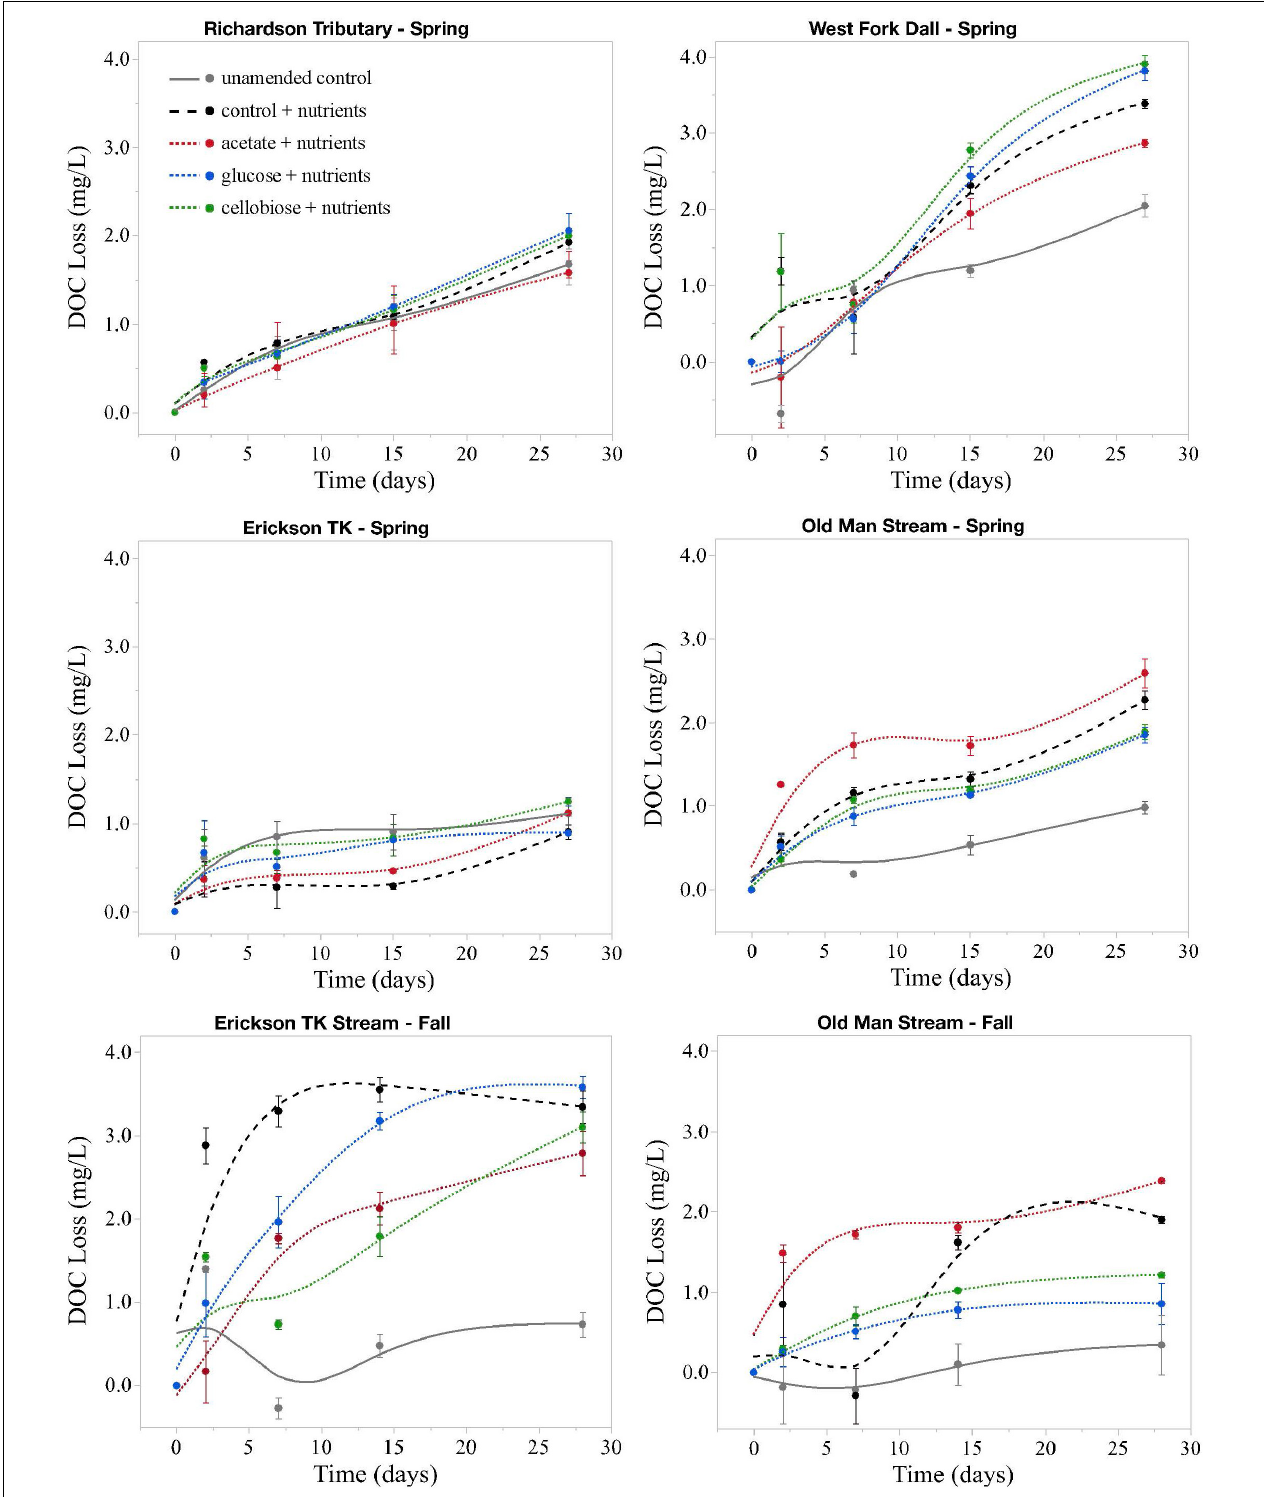
FIGURE 2 | Loss of DOC in microbial incubation experiments. All changes are on the same scale, not exceeding 4 mg L – 1 . Points are average changes in DOC concentration of the three replicates and bars represent one standard error from the mean. Spring = May; Fall = September.